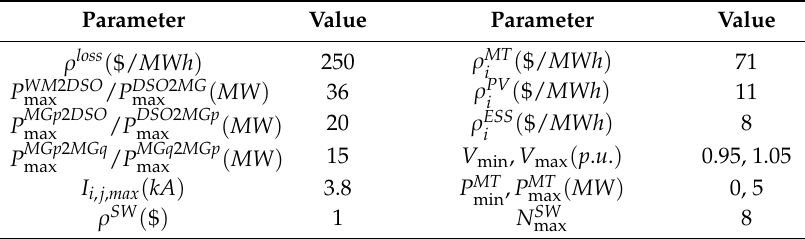
Table 1. Values for technical parameters [29].